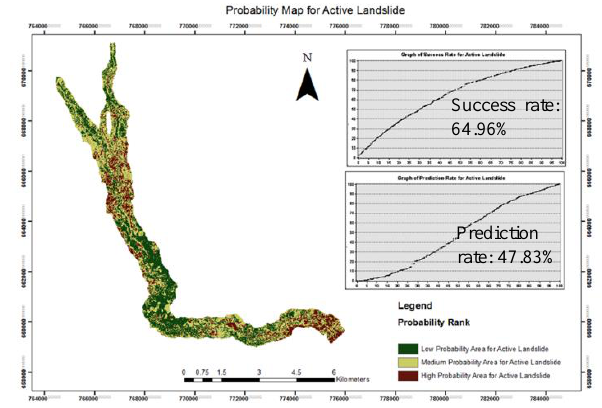
Figure 16. Probability map of active landslide